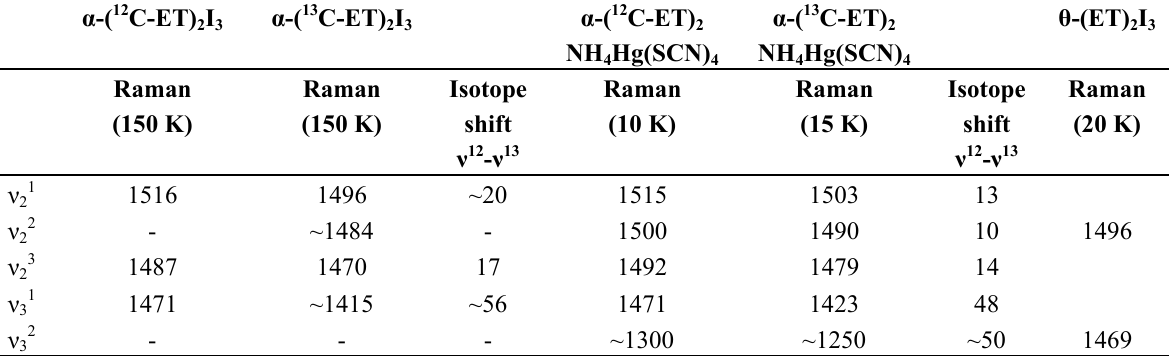
I , α -(BEDT-TTF) 2 3